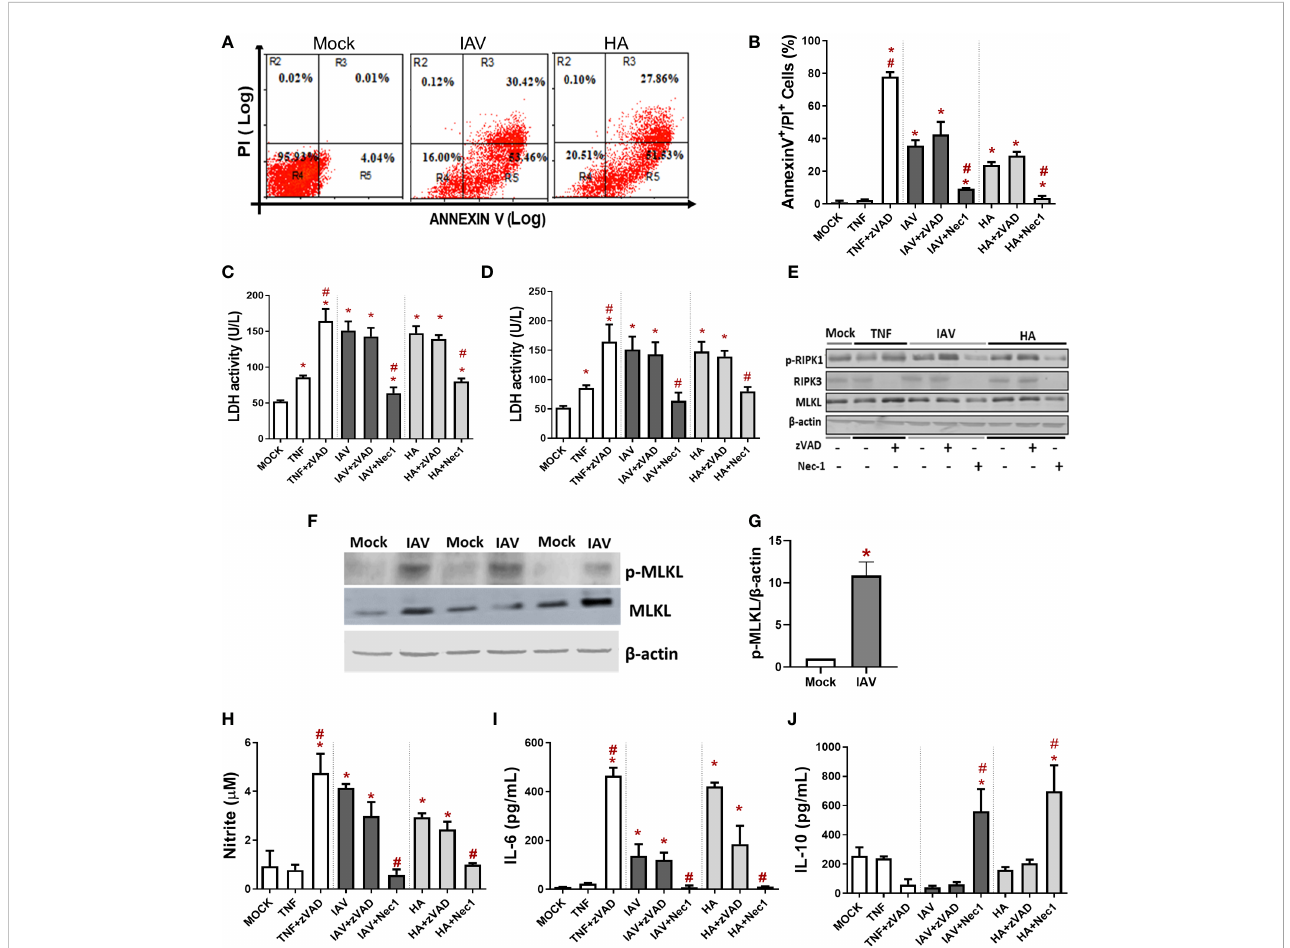
FIGURE 1 IAV and viral HA induce in fl ammatory programmed cell death in primary macrophages. Murine (BMDM) or human macrophage (MDM) cultures were pretreated with zVAD (10 µM) or Nec-1 (25 µM), infected with IAV at an MOI of 0.25, and exposed to 10 ng/mL HA or 1 ng/mL TNF- a . (A, B) BMDM cell death was also evaluated by fl ow cytometry analysis of Annexin V/PI-positive cells. Assessment of cell viability through the measurement of LDH release in the supernatant of BMDMs (C) or humans (D) . (E) The expression of p-RIPK1, RIPK3 and MLKL was detected in BMDM lysates by Western blotting. b - actin levels were used as a control for protein loading. (F) The expression of p-MLKL was detected in BMDMs by Western blotting. b -actin levels were used as a control for protein loading. (G) Graphs of band densitometry of MLKL and p-MLKL obtained after loading normalization and expressed as fold change over mock control. Data are presented as the mean ± SEM of 3 independent experiments * P < 0.05 versus the control group (MOCK); (H) Levels of nitrite were measured by the Griess method in the supernatant of BMDM cultures after 24 h of stimulus. The levels of (I) IL-6 and (J) IL-10 were measured by ELISA in the supernatant of BMDM cultures after 24 h of stimulation. Data are presented as the mean ± SEM of 5 independent experiments *P < 0.05 versus control group (MOCK); # P < 0.05 versus the respective untreated infected/stimulated